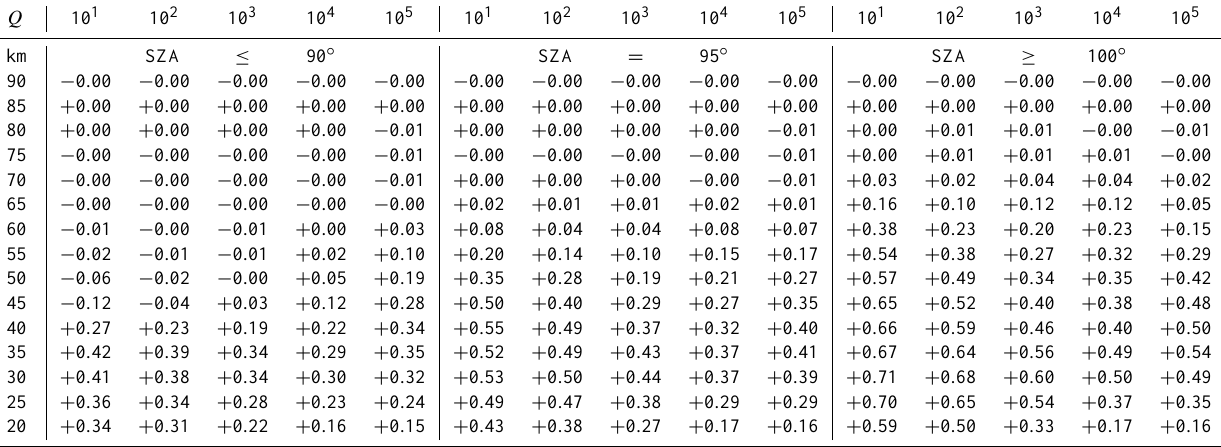
/Q for January SH. 3